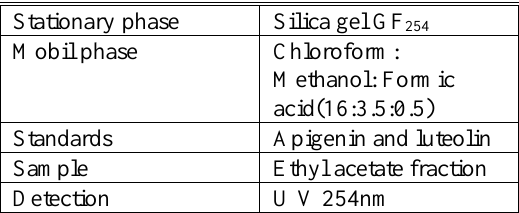
Table 2. Conditions of preparative layer